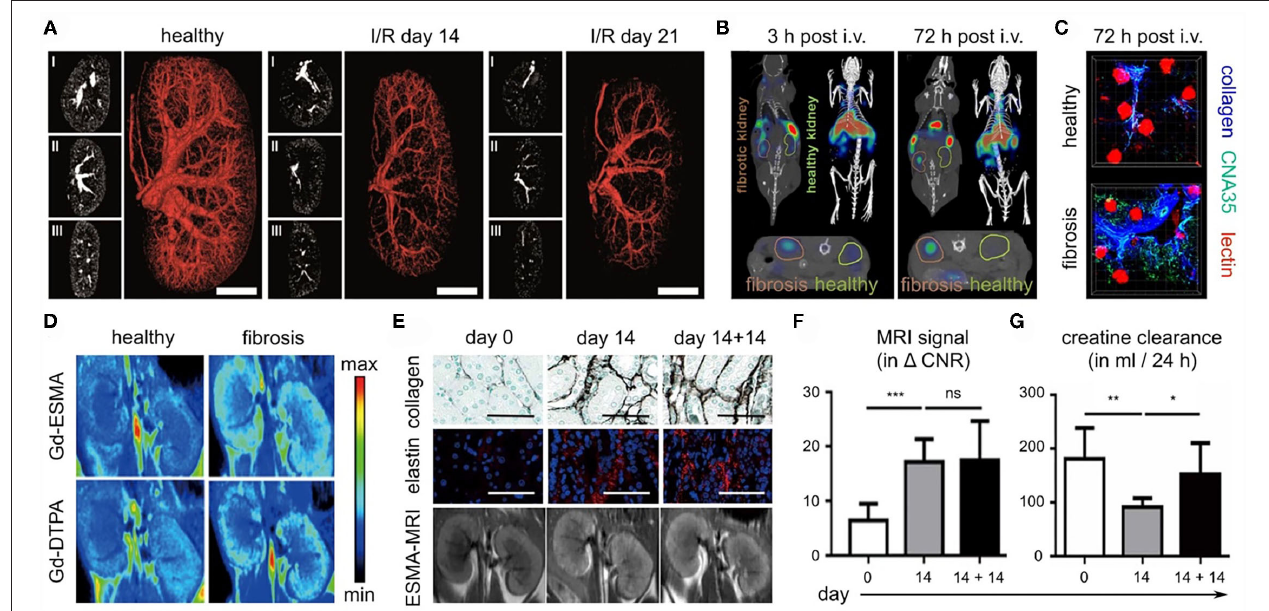
FIGURE 7 | Imaging kidney fibrosis. (A) 2D and 3D images reconstructed from contrast-enhanced micro-CT imaging show progressive vessel rarefaction in mice with I/R-induced kidney fibrosis. Scale bar: 200 µ m. (B) Molecular imaging of collagen deposition in the kidneys of mice with I/R-induced fibrosis, employing CNA35 and CT-FMT. (C) Validation of CNA35 binding to perivascular collagen fibers in mice with I/R-induced kidney fibrosis. Perfused blood vessels are stained with lectin. (D) ESMA-enhanced molecular MR imaging of elastin deposition in the kidneys of mice with adenine diet-induced fibrosis. (E–G) In the adenine reversal model (14 days on adenine diet, then 14 days recovery), ESMA-based molecular MRI can detect residual fibrosis that is not detected by routine kidney function assessment, i.e. analysis of creatinine clearance. Scale bar in (E) : 50 µ m. Images reproduced, with permission, from ( 57–59). For assessing statistical significance, as shown in (F) and (G) , one-way analysis of variance (ANOVA) followed by Bonferroni correction was used. Statistical significance was defined as * p < 0.05; ** p < 0.01; *** p <